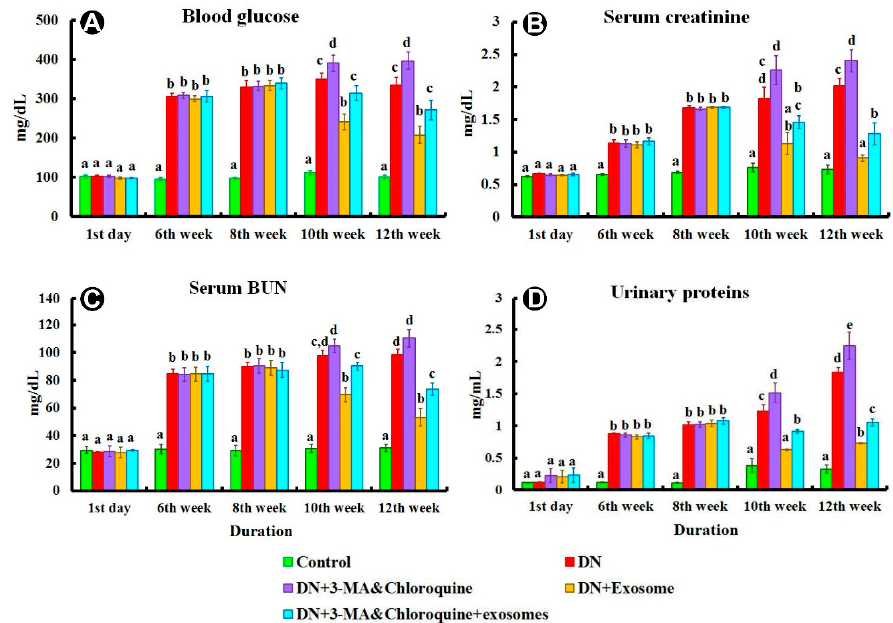
Figure 3. ( A ) Blood glucose, ( B ) serum creatinine, ( C ) blood urea nitrogen (BUN), and ( D ) urinary proteins from different experimental groups. Subgroup Ic was used as a control. Different superscripts (a, b, c, d, and e) at the same checkpoint indicate significant differences at p < 0.05. Data are shown as mean ± SEM, n = 7.